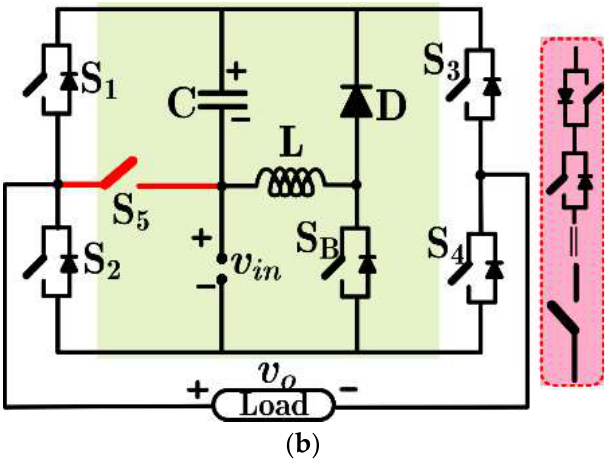
Figure 1. ( a ) Schematic diagram of microgrid system for small scale DES; ( b ) proposed 5L-SB in- verter topology (L—inductor, D—diode, C—capacitor, v in —input voltage, v o —output voltage, S 1 -S 5 , S B —switches).